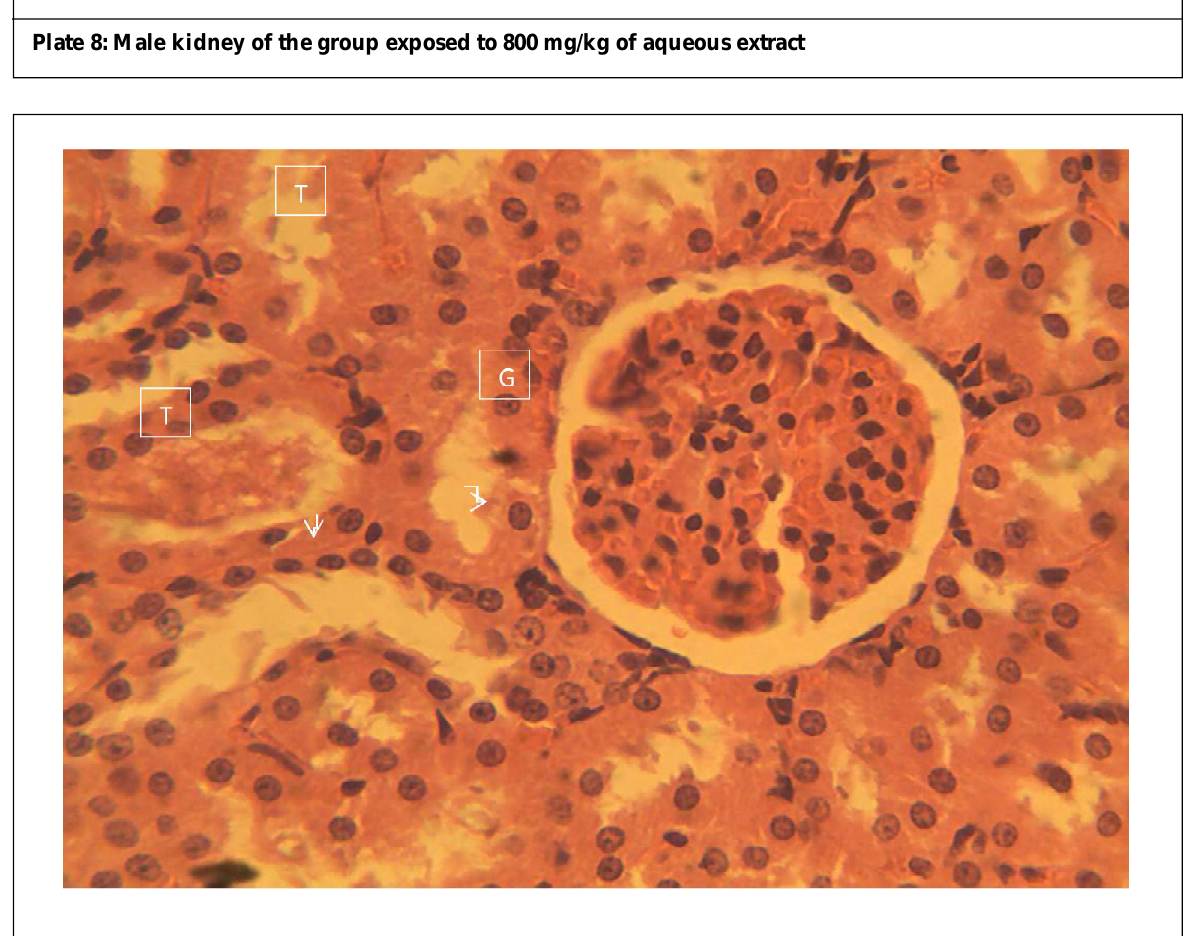
Plate 9: Male kidney of the group exposed to 200 mg/kg of methanol